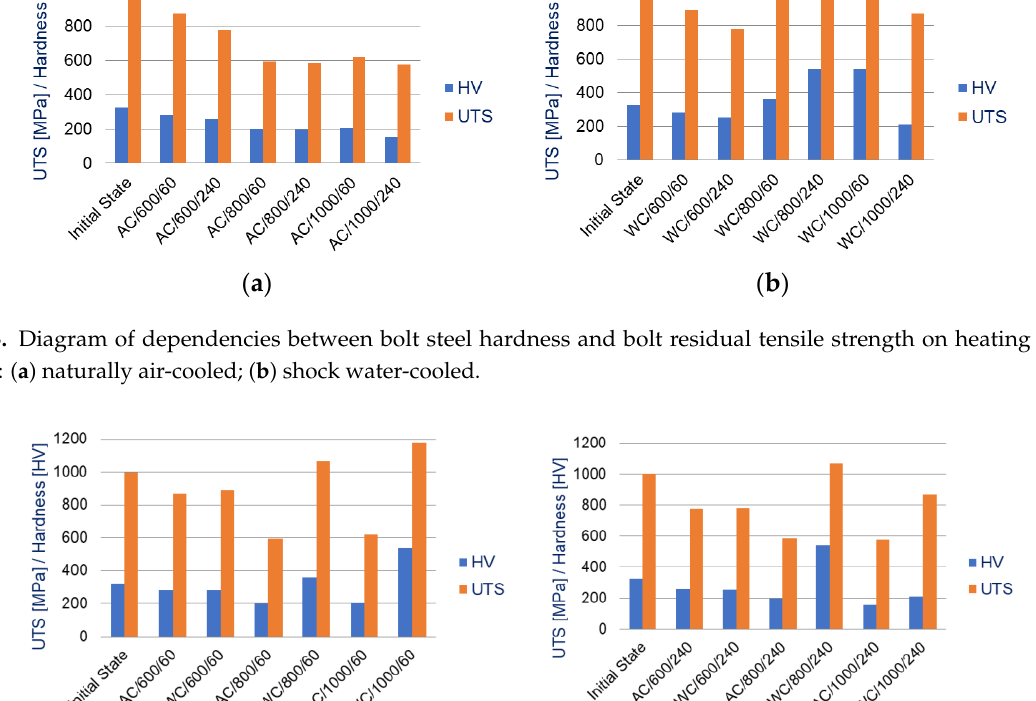
Figure 2. Diagram of correlations between hardness HV and residual tensile strength of the bolt steel after secondary heat treatment depending on parameters of this treatment.